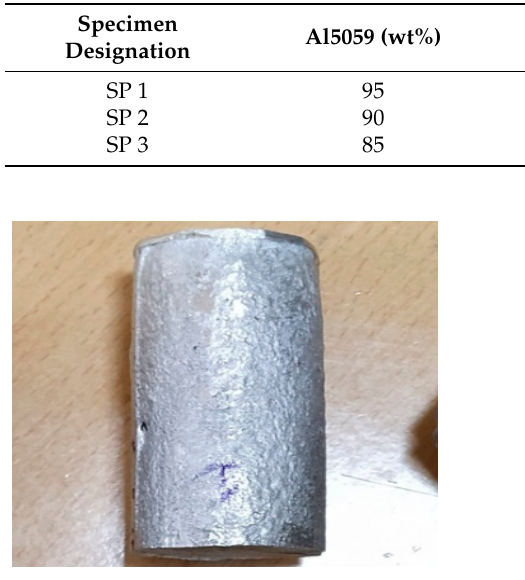
Figure 1. Fabricated hybrid composite sample using stir casting process. Table 1. Chemical composition of Al5059.